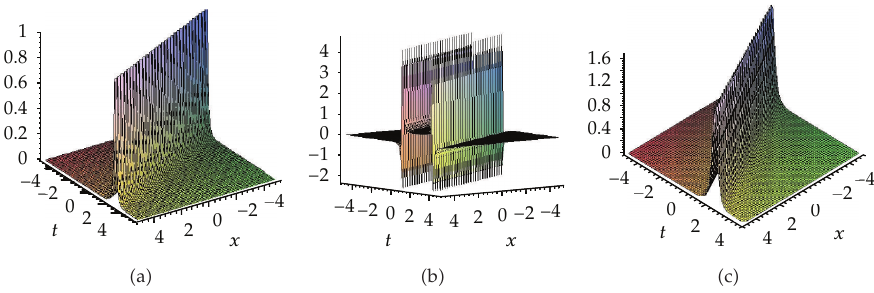
Figure 7: Evolutional behaviour of the intensity | u 1 | 2 describes the bright soliton: (cid:3) a (cid:4) p (cid:7) 1 ,q (cid:7) 1; (cid:3) b (cid:4) p (cid:7) 1 / 332 ,q (cid:7) 1 / 333 (cid:3) singular wave solution (cid:4) ; (cid:3) c (cid:4) p (cid:7) 2 . 132 ,q (cid:7) 1 .